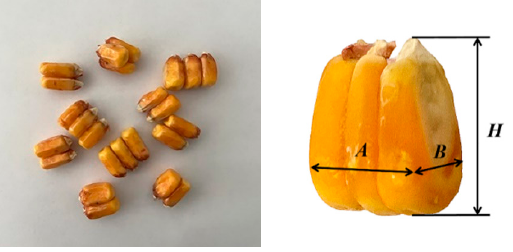
Figure 5. Adhering kernels and their characteristic dimensions.